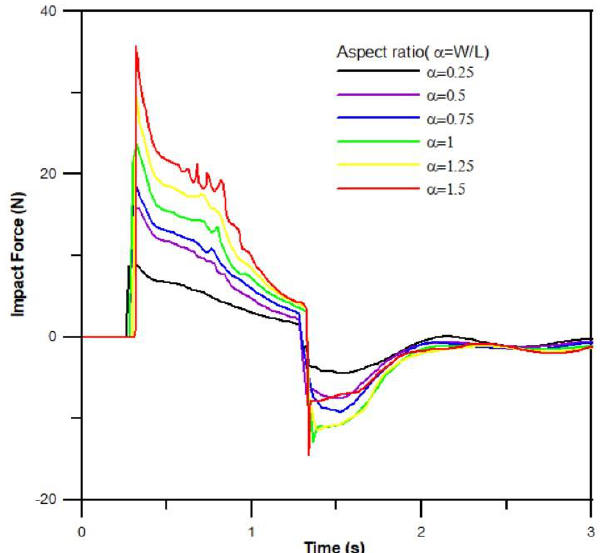
Figure 6. Variations of the impact forces with respect to time for the different aspect ratios of the vertical rectangular cylinder.